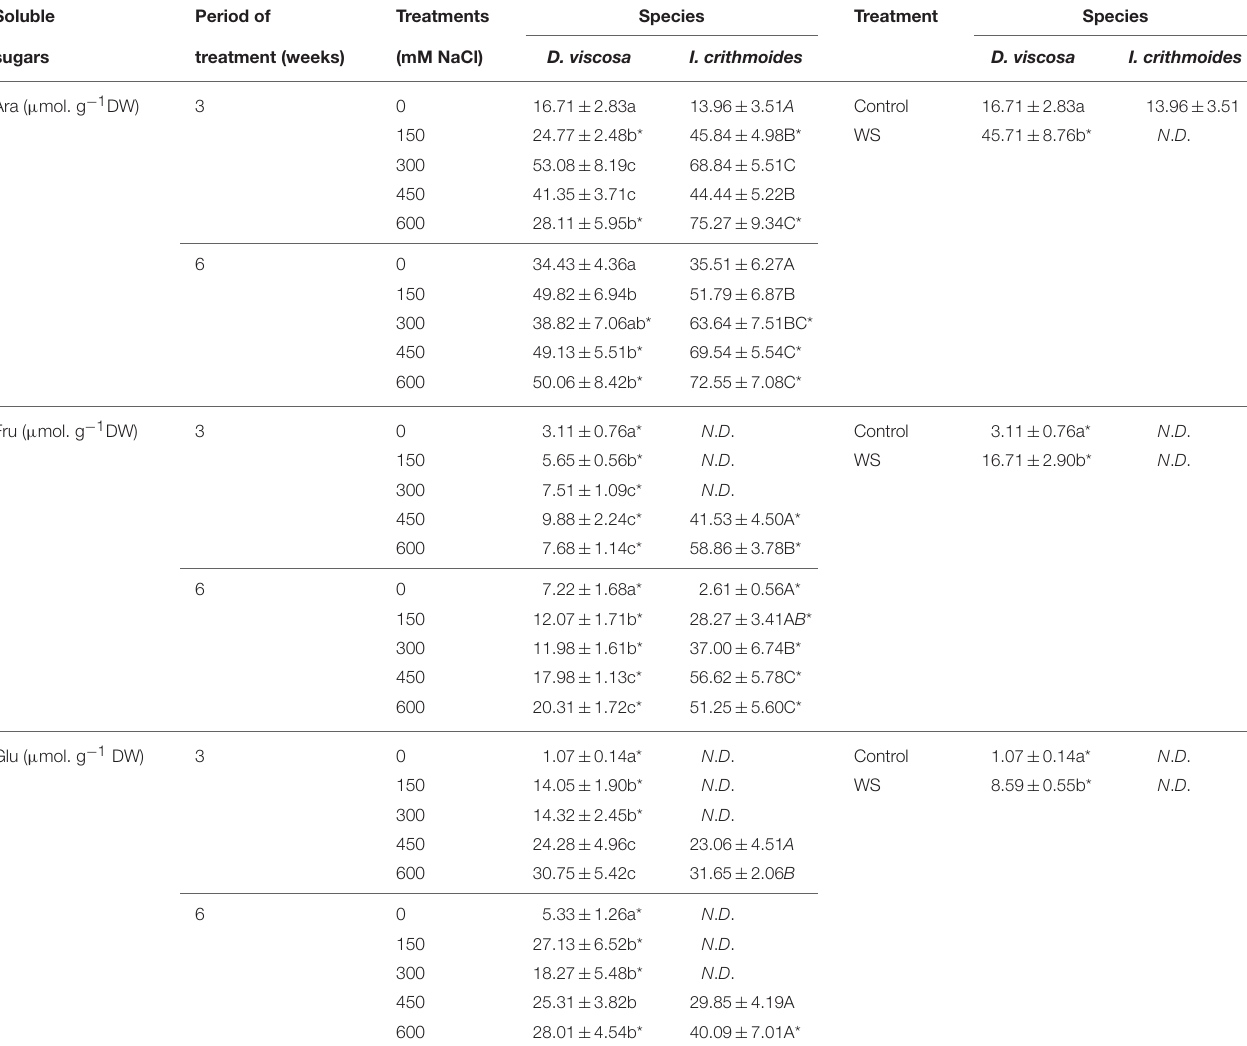
TABLE 2 | Soluble sugars in leaves of salt-treated and water-stressed D. viscosa and I. crithmoides plants. Soluble Period of Treatments Species Treatment Species sugars treatment